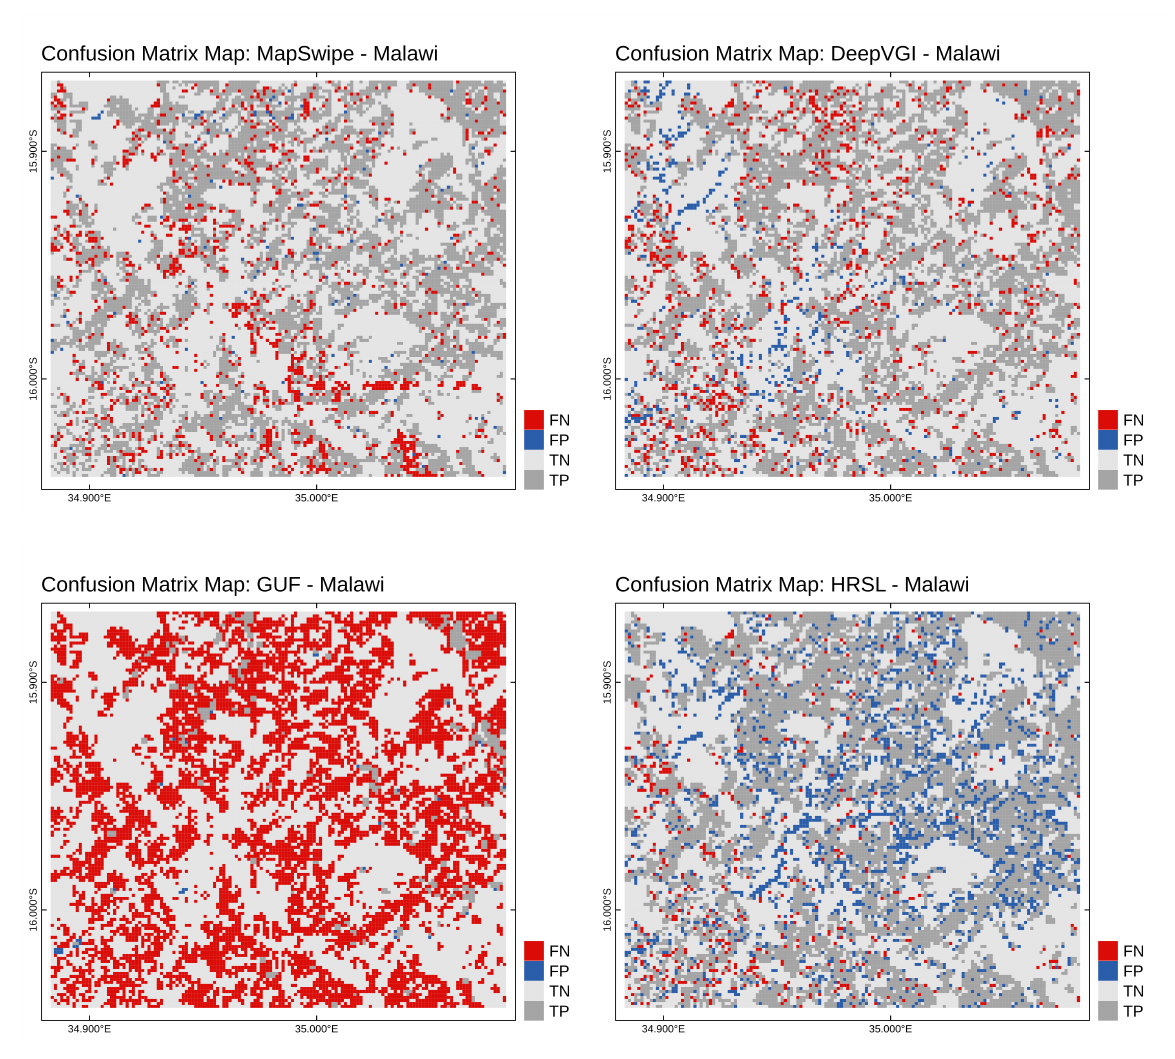
Figure 5. Map representation of the confusion matrix for Malawi: Each map shows the spatial distribution of correct “building” (TP) and “no building” (TN) classifications for a specific method in the testing area. Incorrect classifications are split into false positives (FP) and false negatives (FN). Each pixel corresponds